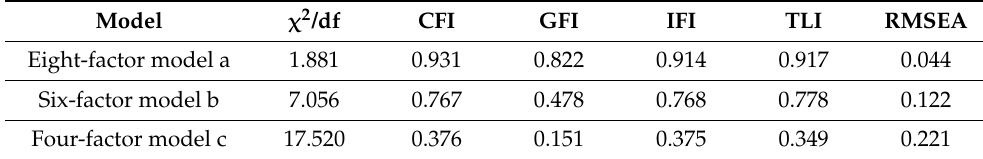
Table 4. Results of the confirmatory factor analysis.